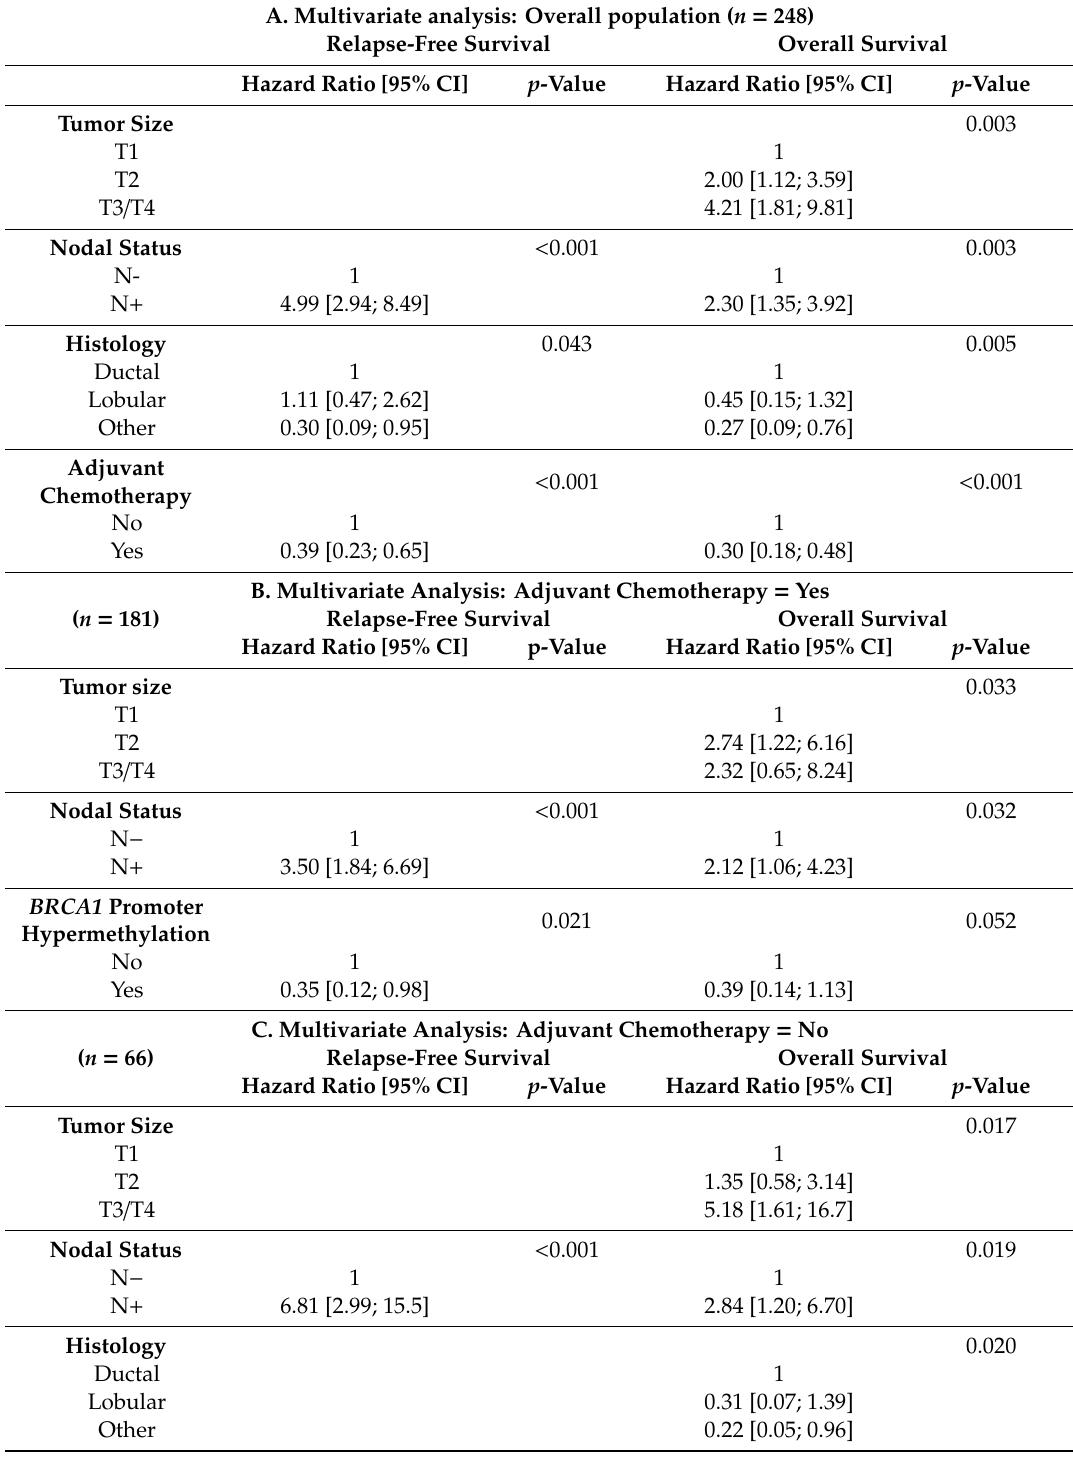
Table 4. Multivariate analysis (Relapse-Free